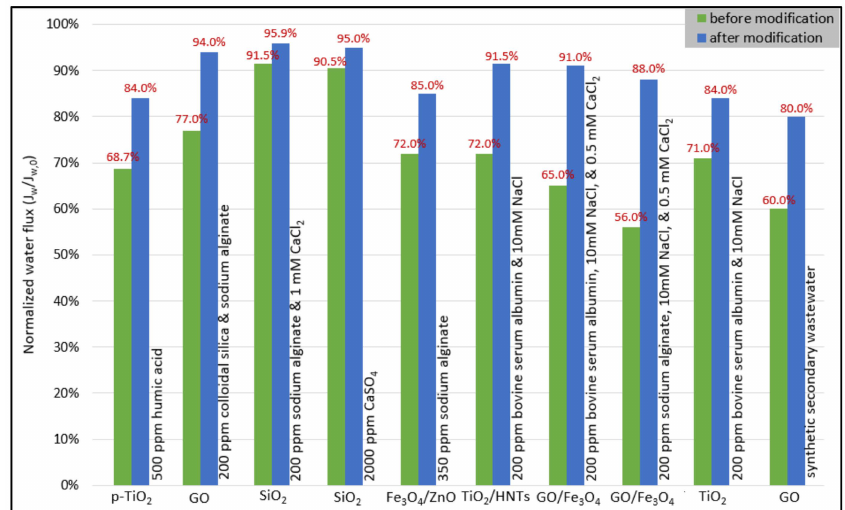
Figure 14. The effect of p-TiO 2 [46], GO [69], SiO 2 [81], Fe 3 O 4 /ZnO [89], TiO 2 /HNTs [94], GO/Fe 3 O 4 [100], TiO 2 [161], and GO [162] on various foulants of the composite membrane in FO mode.